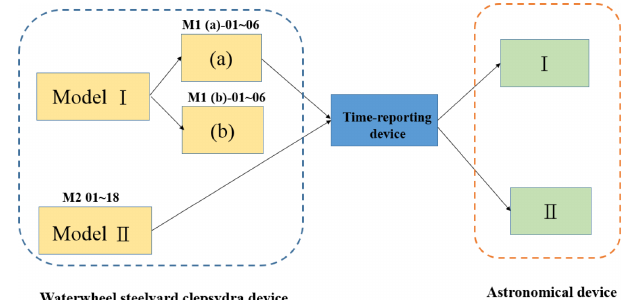
Figure 24. Configurations of the three